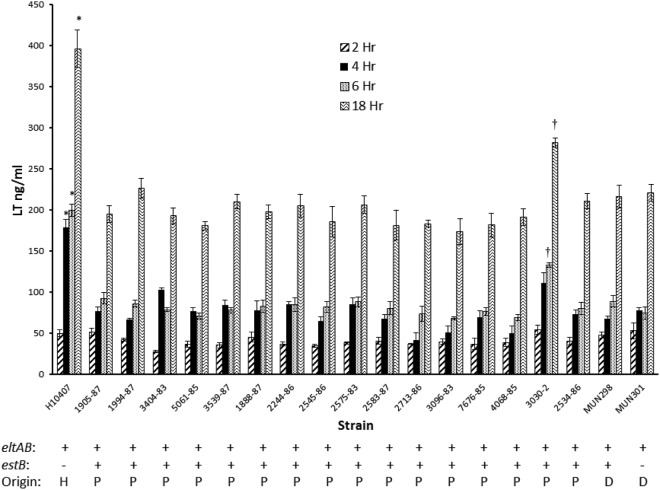
Heat-labile enterotoxin (LT) secretion into culture supernatant over time by human- and porcine-origin enterotoxigenic E. coli strains grown in CAYE-M medium.Strains were cultured at 37°C and 225 rpm in CAYE-M using a flask-to-medium ratio of 8.3:1. Samples of culture supernatants were obtained at 2, 4, 6 and 18 h of incubation, and LT concentrations in supernatant samples at each time interval were determined by GM1-ELISA. *LT concentrations in H10407 culture supernatant are significantly different (P<0.05) from that of all other strains at the corresponding time interval. †LT concentrations in 3030–2 culture supernatant are significantly different (P<0.05) from that of all other porcine or 2534–86 derivative strains at the corresponding time interval. eltAB: strain is positive for LT genes by PCR. estB: strain is positive for STb gene by PCR. H = human-origin strain, P = porcine-origin strain, D = 2534–86 derivative strain.